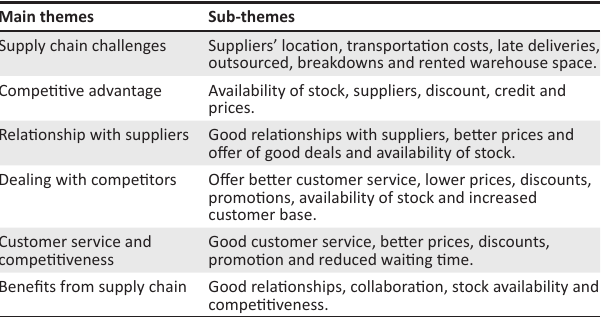
TABLE 1: Main themes and sub-themes that emanated from thematic data